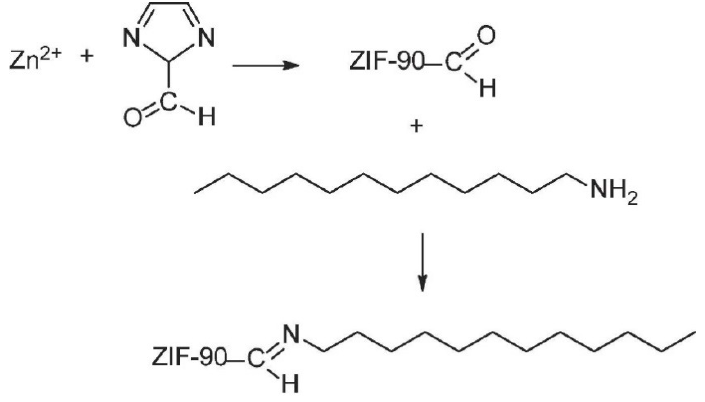
Figure 7. Schematic of the chemical reaction and DLA modification of ZIF-90 particles.